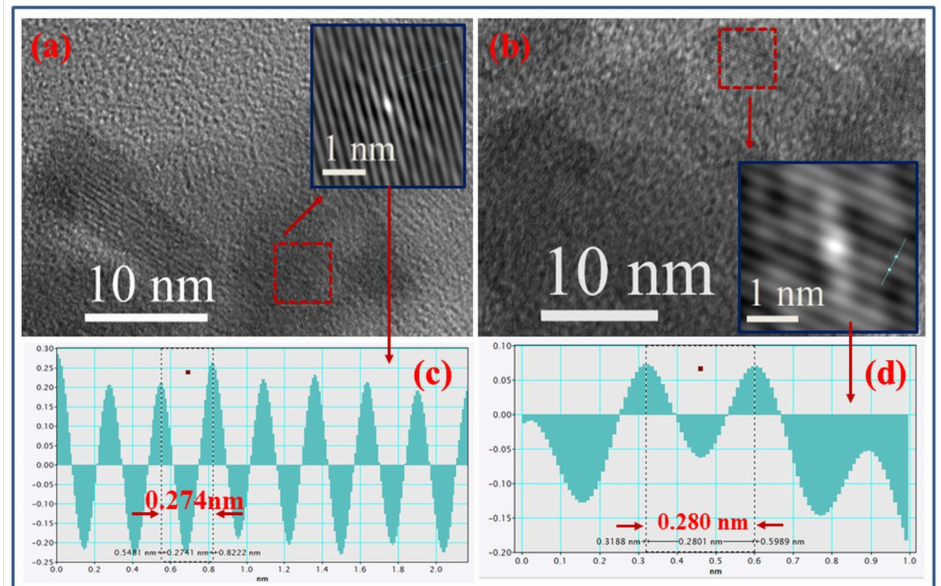
Figure 3. High-resolution TEM image of Zn (1 − x) Li x O nanocrystalline samples ( a ) x = 0.0 and ( b ) x = 0.07 samples. The inset of ( a , b ) represents the autocorrelated images of the selected por- tion of the images. The intensity profile of the autocorrelated images used to measure the interplanar distance for ( c ) x = 0.0 corresponding to the (002) plane and ( d ) x = 0.07 corresponding to the plane